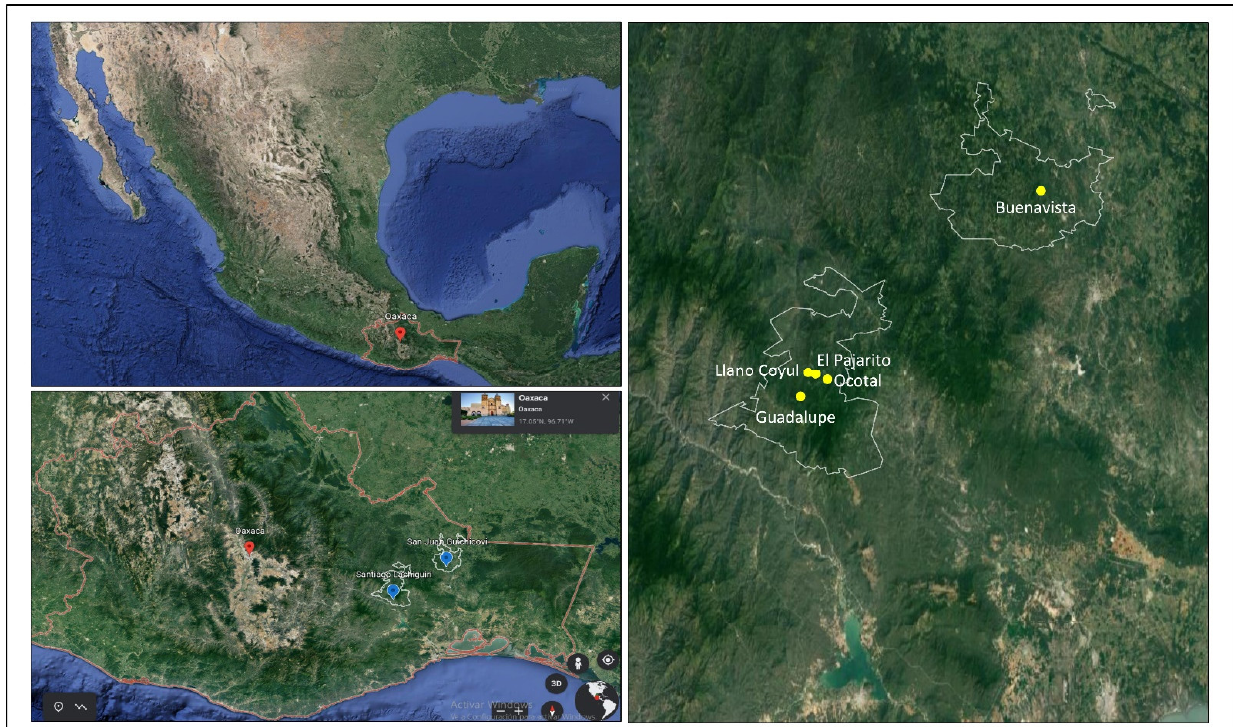
Figure 1. Location of El Pajarito, Llano Coyul, Ocotal, Guadalupe, and Buenavista in Santiago Lachiguiri and San Juan Guichicovi in Oaxaca, Mexico. Table 2. Social and digital contexts of El Pajarito, Llano Coyul, Ocotal, Guadalupe, and Buenavista in Santiago Lachiguiri and San Juna Guichicovi in Oaxaca, Mexico.